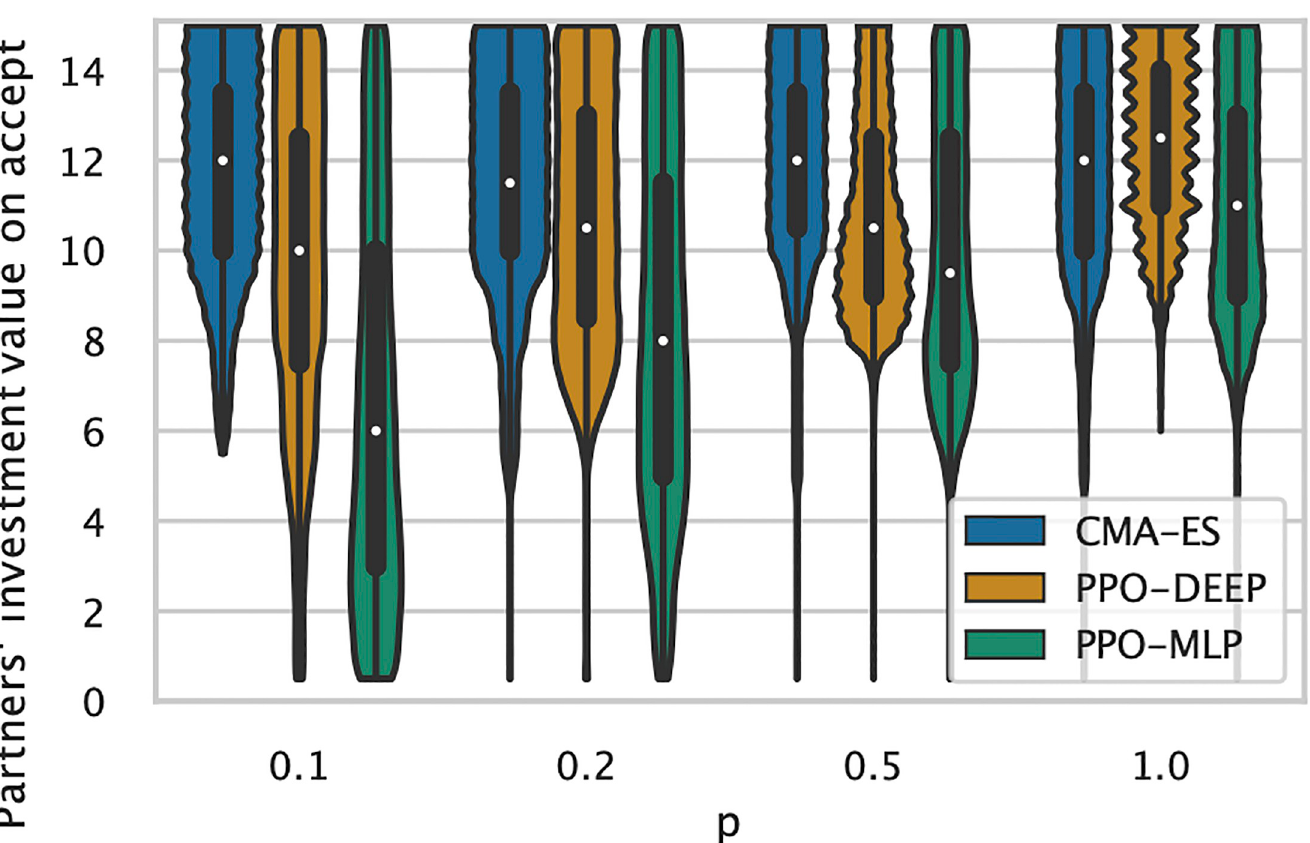
Fig 6. Decision to accept to cooperate taken by the focal agent, when facing a cooperative partner with a particular investment value. Results for CMAES (blue), PPO-DEEP (orange) and PPO-MLP (green) are shown as violin graph. X-axis: algorithms and conditions, Y-axis: partner’s investment value for which the focal agent accept to